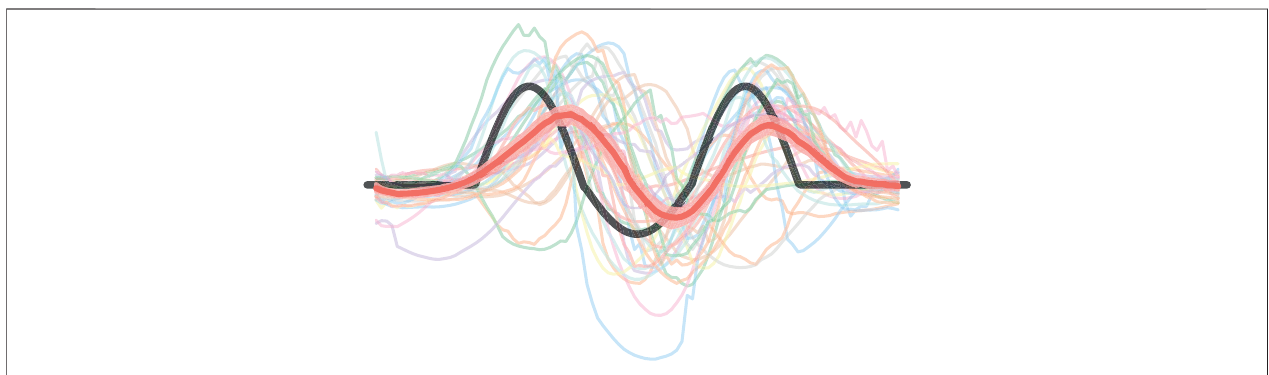
FIGURE 3 | Line plots of fi nger movements (X,Y) for a particular gesture. The thick black line denotes the target gesture, the red line shows the mean gesture performed across all participants with the error band showing the 0.99 CI. The thin colored lines each represent the mean gesture across one participant ’ s trials. Together the plot shows valid fi nger tracking data from unsupervised VR